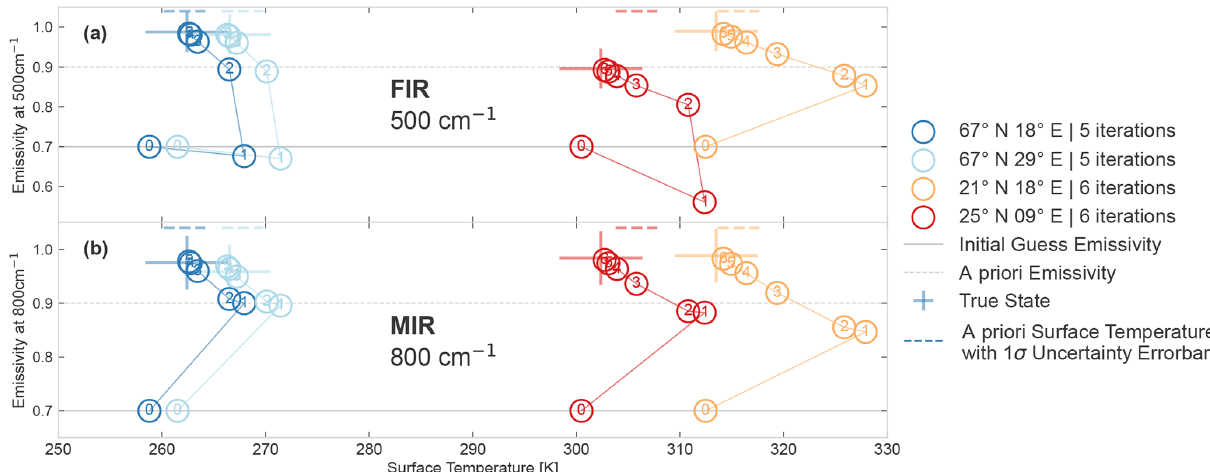
Figure A2. Value of two elements of the retrieval vector for all retrieval iterations in the emissivity, with surface temperature ( T s ) parameter space for four different scenes. The four colour-coded scenes are shown (67 ◦ N, 18 ◦ E; 67 ◦ N, 29 ◦ E; 21 ◦ N, 18 ◦ E; and 25 ◦ N, 09 ◦ E) in dark blue, light blue, orange and red, respectively, with details as outlined in Sect. 3. The structure of the figure is similar to that of Fig. A1. For the four retrievals, the scattered coloured circular markers show the values of the emissivity and T s at each numbered iteration of the retrieval starting from the initial guess until the converged solution. The retrieval parameters are the same for all scenes, with an emissivity a priori of 0.9 and an initial guess of 0.7 (all others have the default values outlined in Sect. 3). The y axis of panels (a) and (b) show the value of the emissivity at 500 and 800cm − 1 , respectively, with a shared x axis showing the surface temperature. Both figures also show the a priori emissivity and initial guess emissivity as dashed and solid grey lines, respectively. The different ± 1 σ a priori uncertainty range for T s is shown as a dashed line at the top of the plot (the y -axis location has no significance other than clarity), with the same colour coding as the circular markers. This colour-coding is also used for the solid cross centred at the true values of emissivity and T s of the scenes.